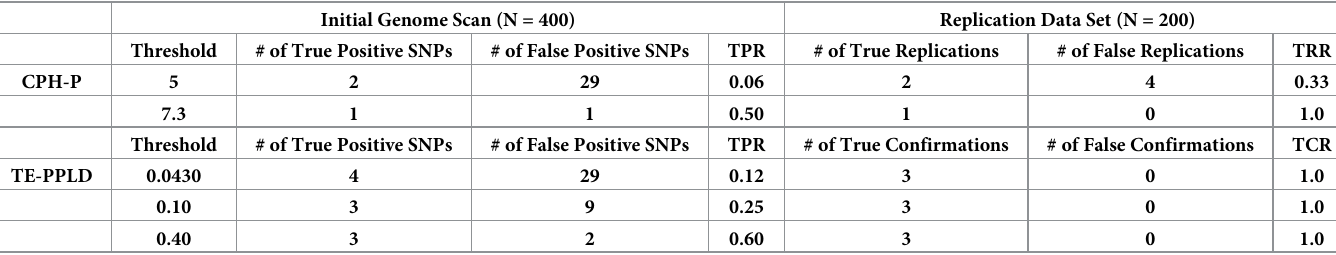
Table 10. True Positive Rates (TPR) for initial genome scan (N = 400) and True Replication (Confirmation) Rates (N = 200), using various thresholds.